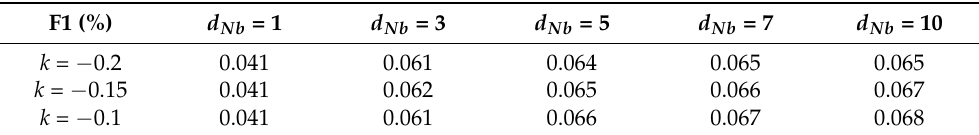
Table 4. Niblack’s algorithm tuning. F1 index vs. k and d Nb . The first parameter varies along the